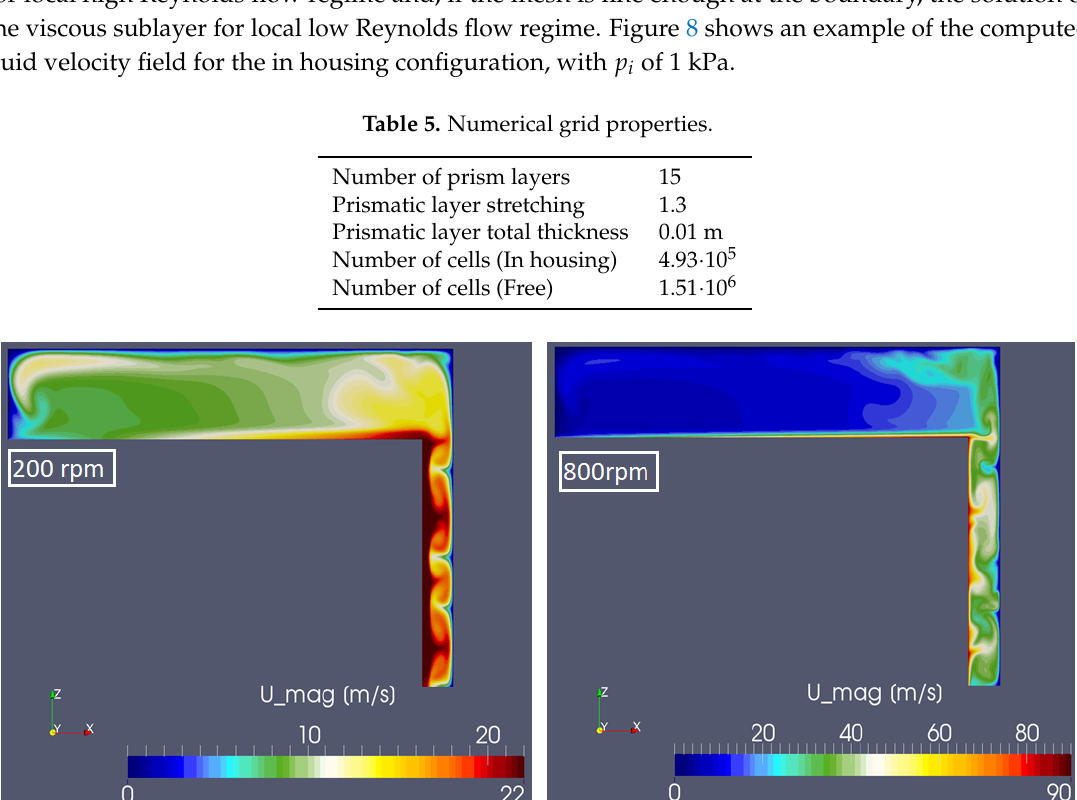
Figure 8. Fluid velocity field for the in housing configuration, with p i of 1 kPa and ˙ ϕ of 200 rpm and 800 rpm, on the left and right of the figure,